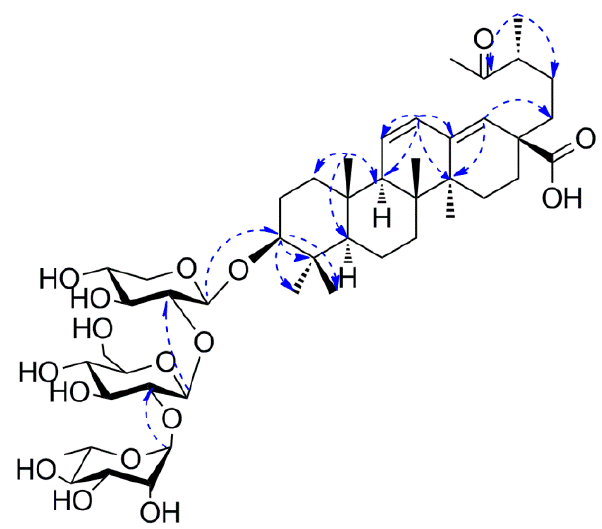
Figure 2. Key HMBC correlations of compound 1.